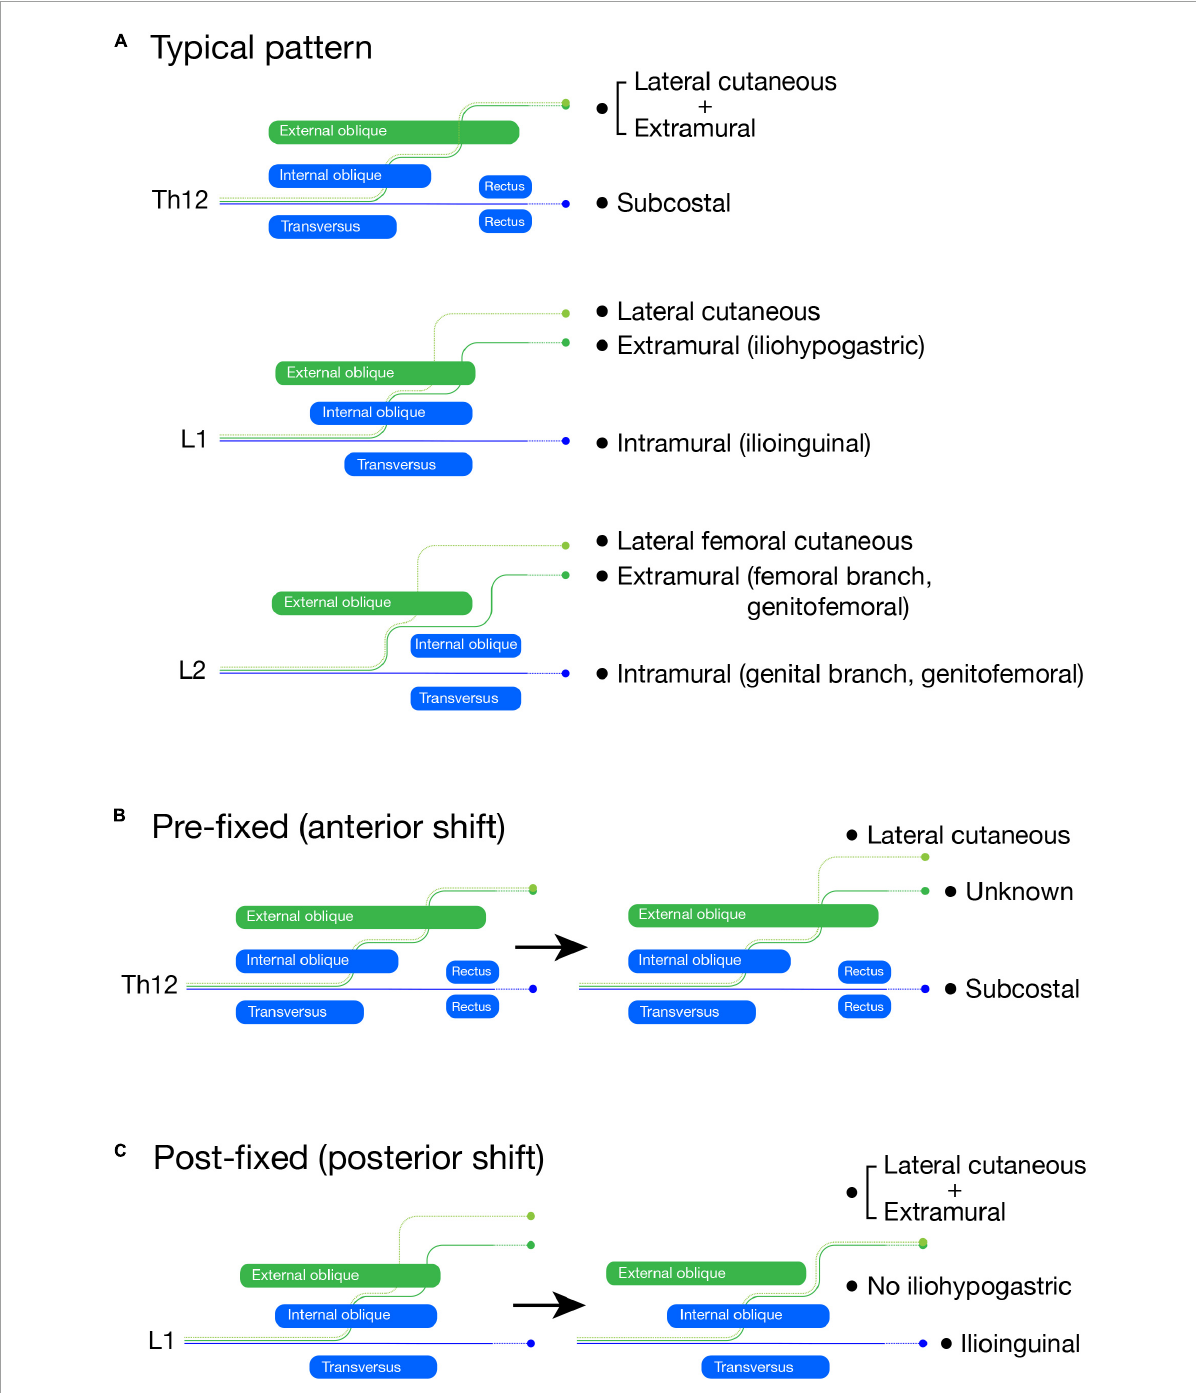
FIGURE15 Schematic illustration of the lumbar plexus formation. The LCBs are light green, the extramural branches are green, and the intramural branches are blue. In the typical branching pattern (A) , the Th12 is the subcostal nerve (blue, intramural branch) with the lateral cutaneous and extramural branches, which are tied together. The L1 spinal nerve bifurcates into the iliohypogastric (extramural branch) and ilioinguinal (intramural branch) nerves. The LCB is usually present from the L1 nerve. The L2 spinal nerve also bifurcates into the femoral (extramural branch) and genital (intramural branch) branches of the genitofemoral nerve. The LCB from the L2 nerve is equivalent to the lateral femoral cutaneous nerve. In the pre-fixed plexus (B) , the Th12 (subcostal nerve) bifurcates into the extra and intramural branches like the L1 nerve in the typical pattern. However, we are unable to identify the extramural branch as the iliohypogastric nerve, although we can identify the intramural branch as the subcostal nerve and the LCB. In the post-fixed plexus (C) , the L1 spinal nerve does not bifurcate, which is similar to the subcostal nerve. The ilioinguinal nerve and LCB are there, but the iliohypogastric nerve is not; it is fasciculated with the